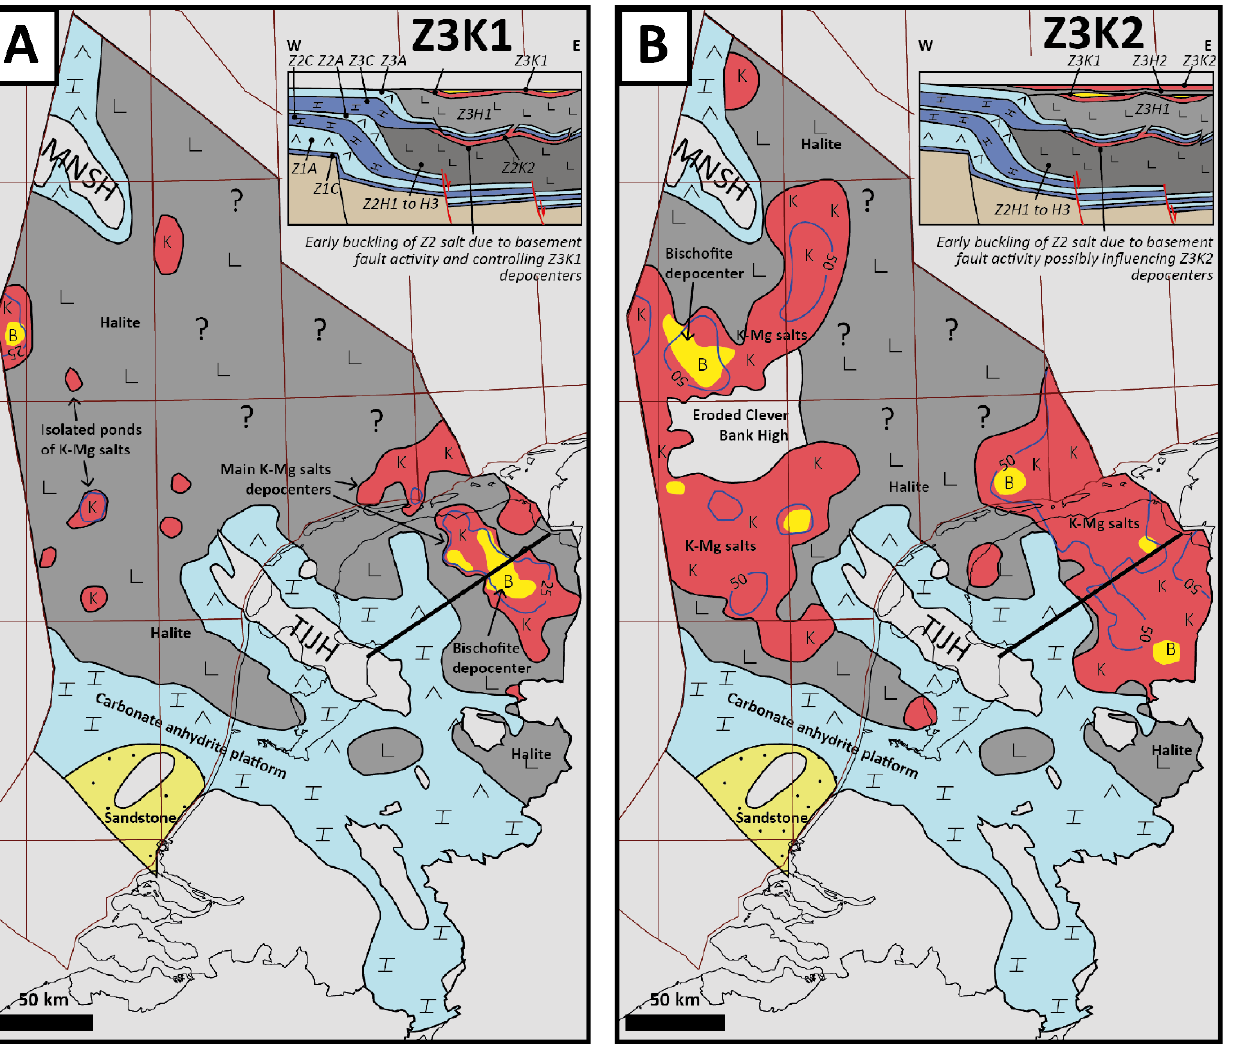
Figure 10. Facies and isopach map of the Z3K1 ( A ) and Z3K2 ( B ) units (modified after [8]) with conceptual sections illustrating the depositional setting (upper right).